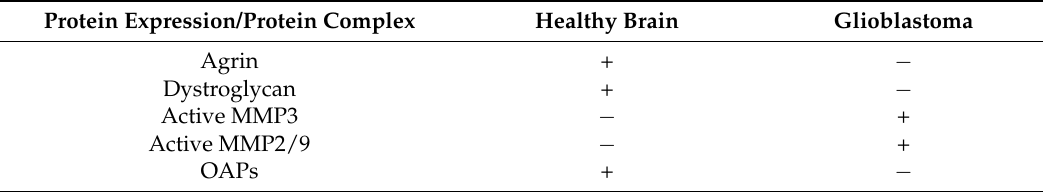
Table 1. Comparison of typical features between healthy brain and